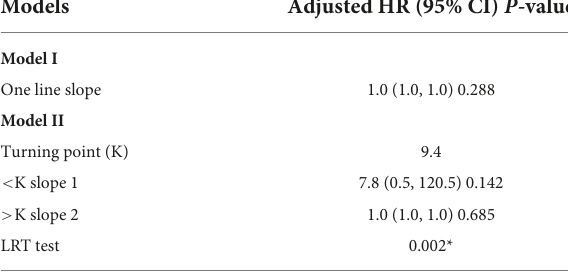
TABLE 4 Threshold analysis for the relationship between onset-to-TEVAR time and follow-up death risk.